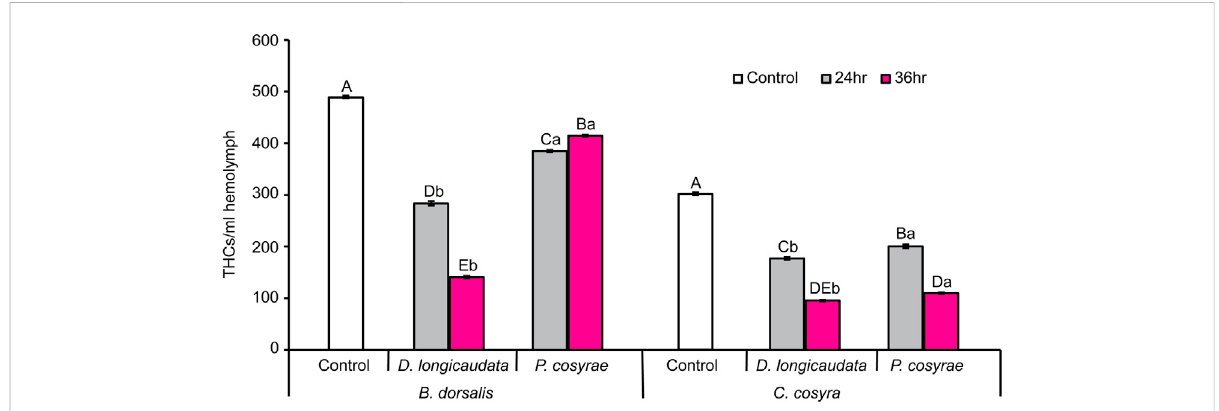
FIGURE 3 Mean host total hemocyte counts over time in B. dorsalis and C. cosyra in response to exposure to the parasitic wasps, D. longicaudata and P. cosyra e. Bars capped with different letters within each host species (lowercase letters denote differences across all treatment groups of the same host species while upper case letters denote differences between the different parasitoids analysed at the same time point) are statistically different (Tukey tests: p ≤ 0.05, n = 120). Error bars indicate ±